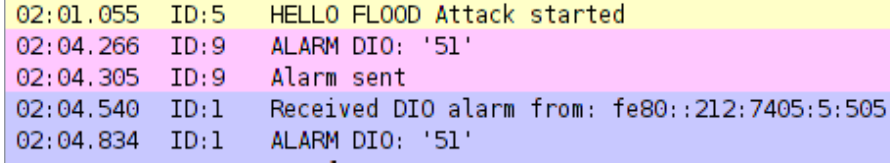
Figure 6. Hello flood attack log showing detection.